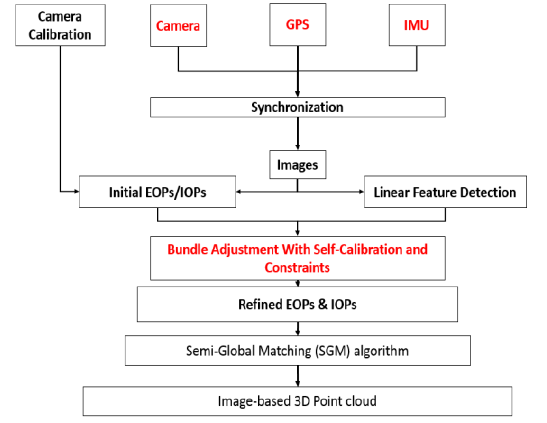
Figure 3. Methodologies Chart